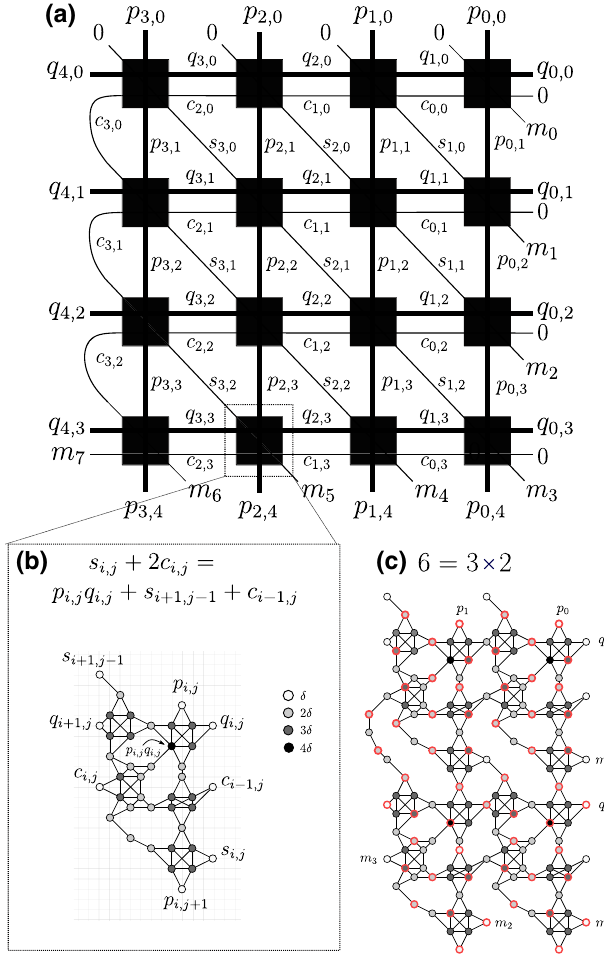
FIG. 8. Encoding procedure for integer factorization. (a) Graphical representation of the set of equations to be satisfied for integer factorization ( m = p · q ). The factor bits p i , q i and binary variables s i , j , c i , j are represented by copy lines to construct an effective square crossing lattice for the problem, with a filled square at crossings and the integer bits m i specifying some of the boundary conditions of the problem. (b) Each filled square rep- resents a set of equality constraints between the binary variables associated with the adjacent legs. The final UDG-MWIS can be obtained by replacing each square with the factoring gadget that enforces the mathematical constraints relevant for the factoring problem. The unit-disk radius should be slightly larger than 2 times the lattice constant. (c) An example of the UDG-MWIS representation of the factoring problem 6 = 3 ×